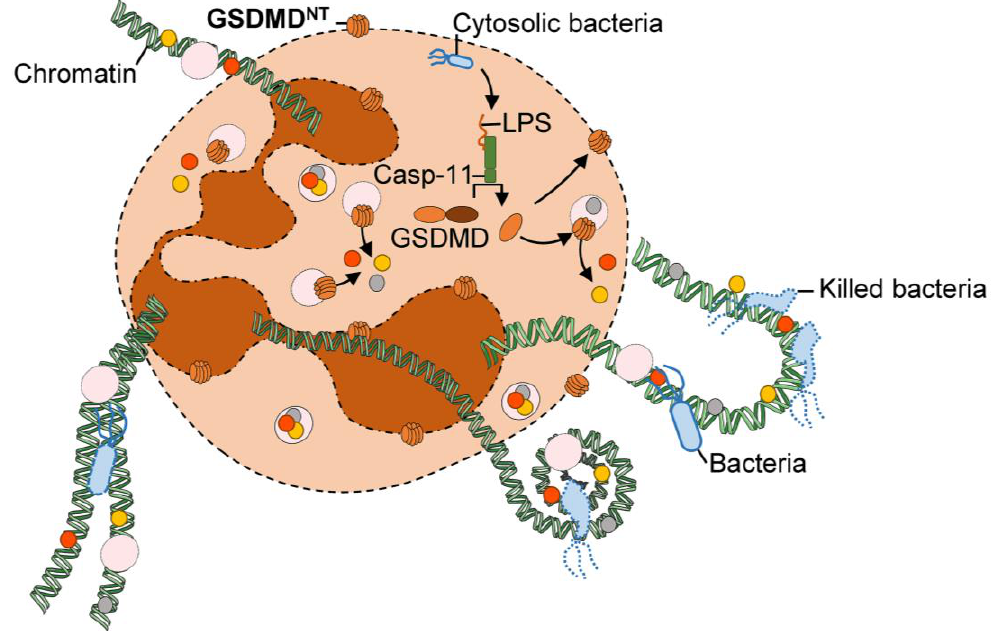
Figure 3. Mechanism of GSDMD-mediated NETosis. The LPS released intracellularly by Gram-negative bacteria binds to the protease caspase-11. In turn, activated caspase-11 highly efficiently cleaves Gasdermin D (GSDMD) which releases GSDMD NT into the cytoplasm of neutrophils. The Gasdermin D N-terminal domain (GSDMD NT ) lytic fragment is localized within the membranes of azurophilic granules and intracellular organelles rather than the plasma membrane of neutrophils. The pore formation in neutrophil organelles enables the release of enzymes and proteases that may participate in nuclear delobulation, histone citrullination, DNA extrusion, and rupture of the nuclear envelope. The activated cells died under the neutrophil-specific program cell death mediating the formation of NET (neutrophil extracellular traps) named as NETosis. Then, NETs are released in the milieu to capture and to kill the bacteria.